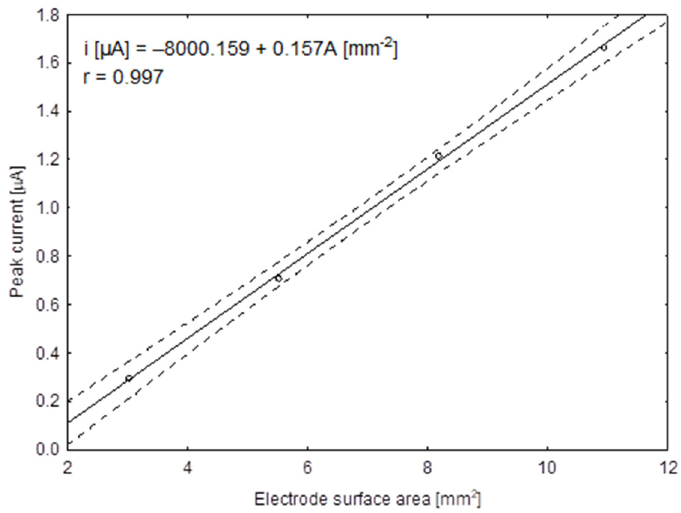
Figure 5. The dependence of peak current on Hg(Ag)FE surface area from 2.7 to 10.7 mm 2 obtained for 0.2 µgmL − 1 of RIF in 0.1 M CH 3 COOH solution.